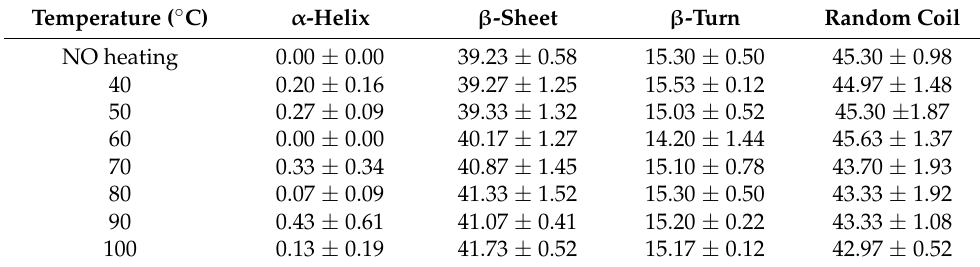
Results are presented as mean values ± standard deviation ( n = 3). The data in each column are not significantly different ( p >